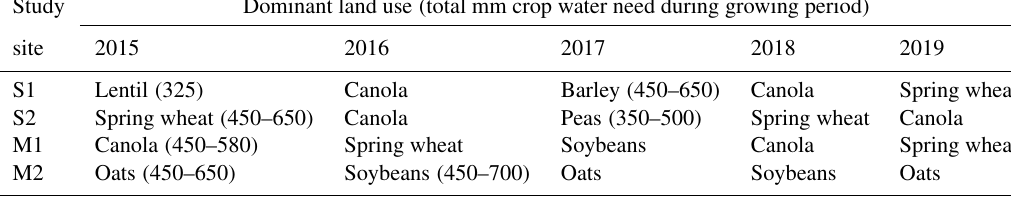
Table 1. Land use from 2015 to